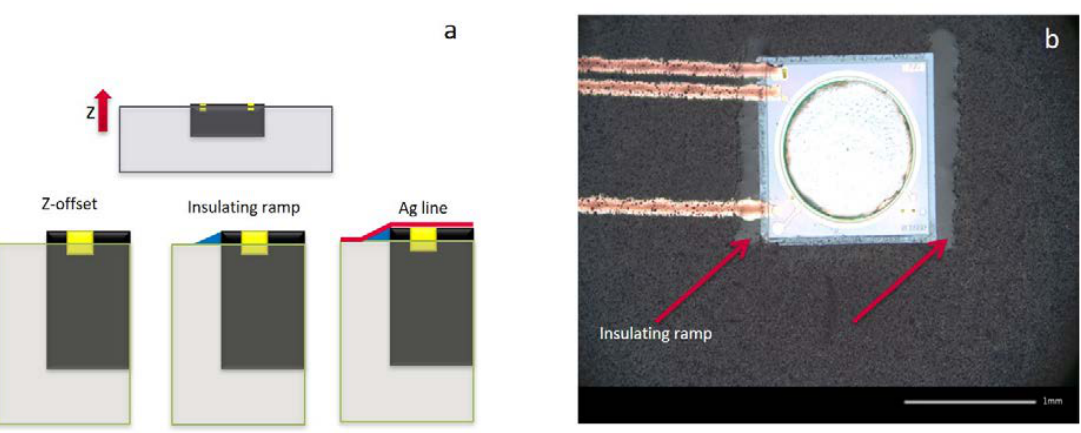
Figure 5. The schematic demonstration ( a ) of the inkjet-printed insulating ramp approach to smoothen the Z-offset and the corresponding optical image ( b ).